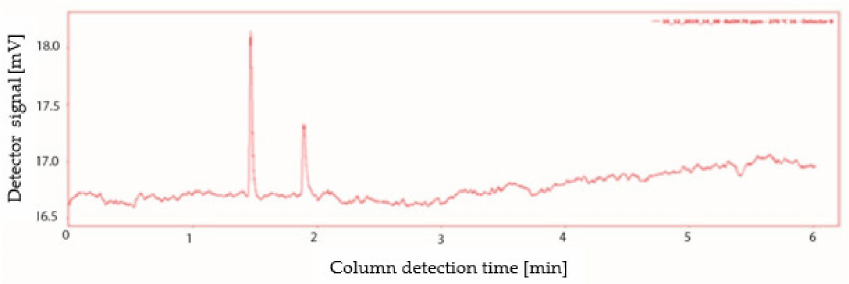
Figure 5. Chromatogram of one of the samples generated with a vaporisation temperature equal to 270 ◦ C; set-up conditions are identical, as in the test showed in Figure 4. In this case, two peaks are present, one at 1.89 min and the second at 1.46 min.